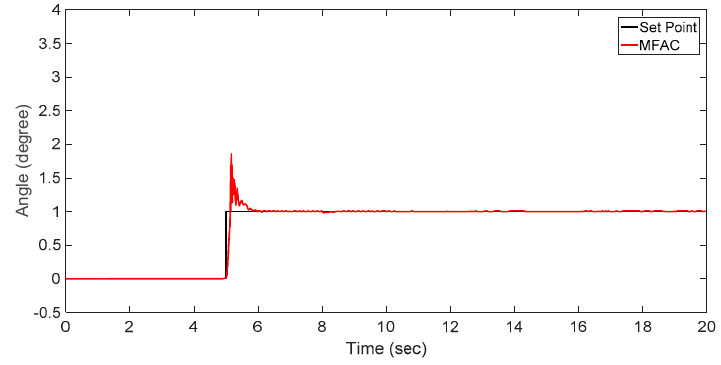
Figure 14. Step response of BLDC Motor using MFAC.